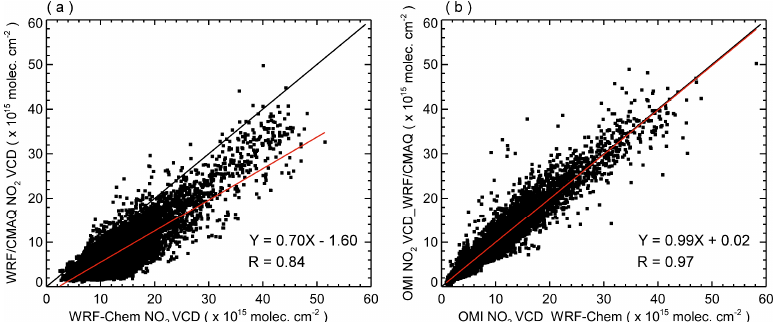
Figure 8. A comparison of (a) the modeled NO 2 VCD and (b) the reconstructed OMI NO 2 VCD by the WRF-Chem and WRF/CMAQ models over the South Korean region. The modeled NO 2 VCD in ( a ) were calculated by applying the KNMI OMI averaging kernels to the modeled vertical profiles of NO 2 concentrations.